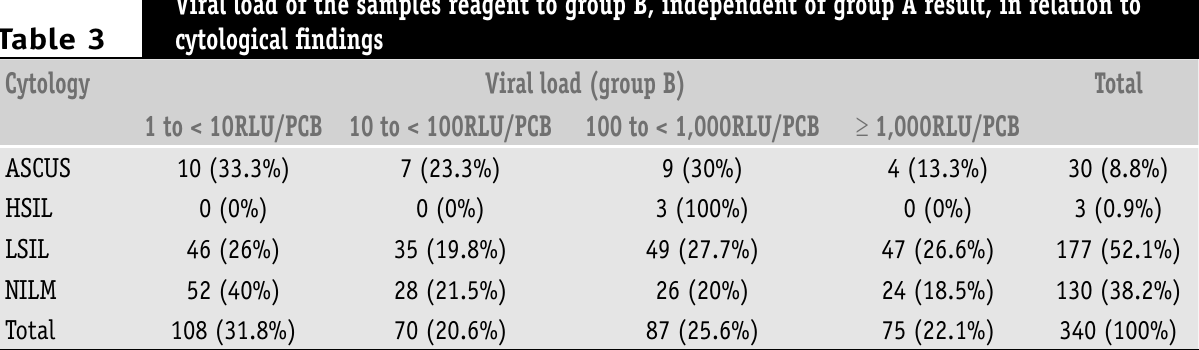
Viral load of the samples reagent to group B, independent of group A result, in relation to cytological findings